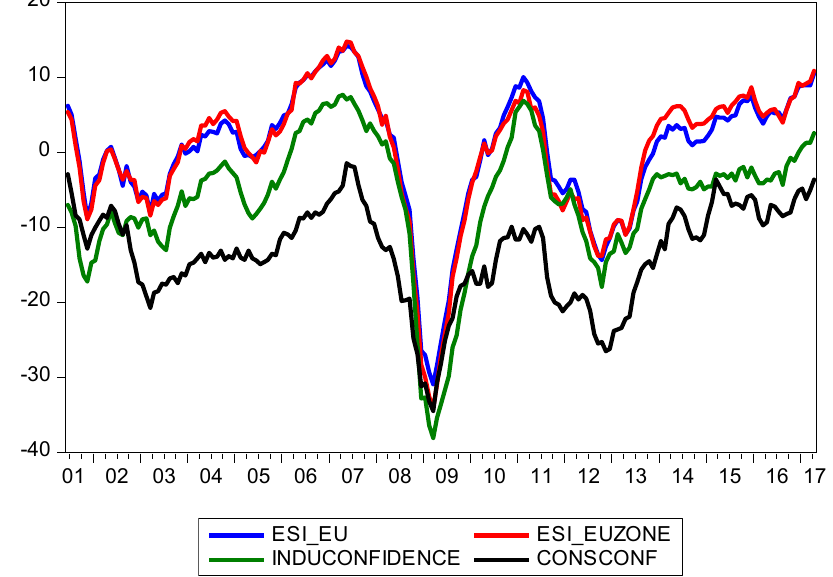
Figure 3. Plot of the sentiment indices group for the entire range 2001–2017.